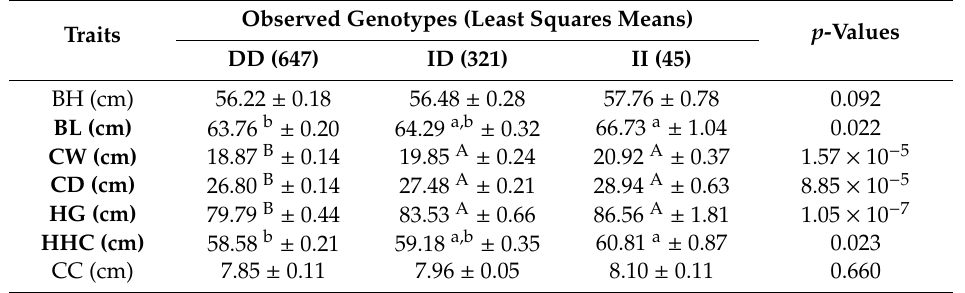
Table 3. The relationship between the HIAT1 gene and growth traits in Shaanbei white cashmere goats ( p < 0.05 / p <